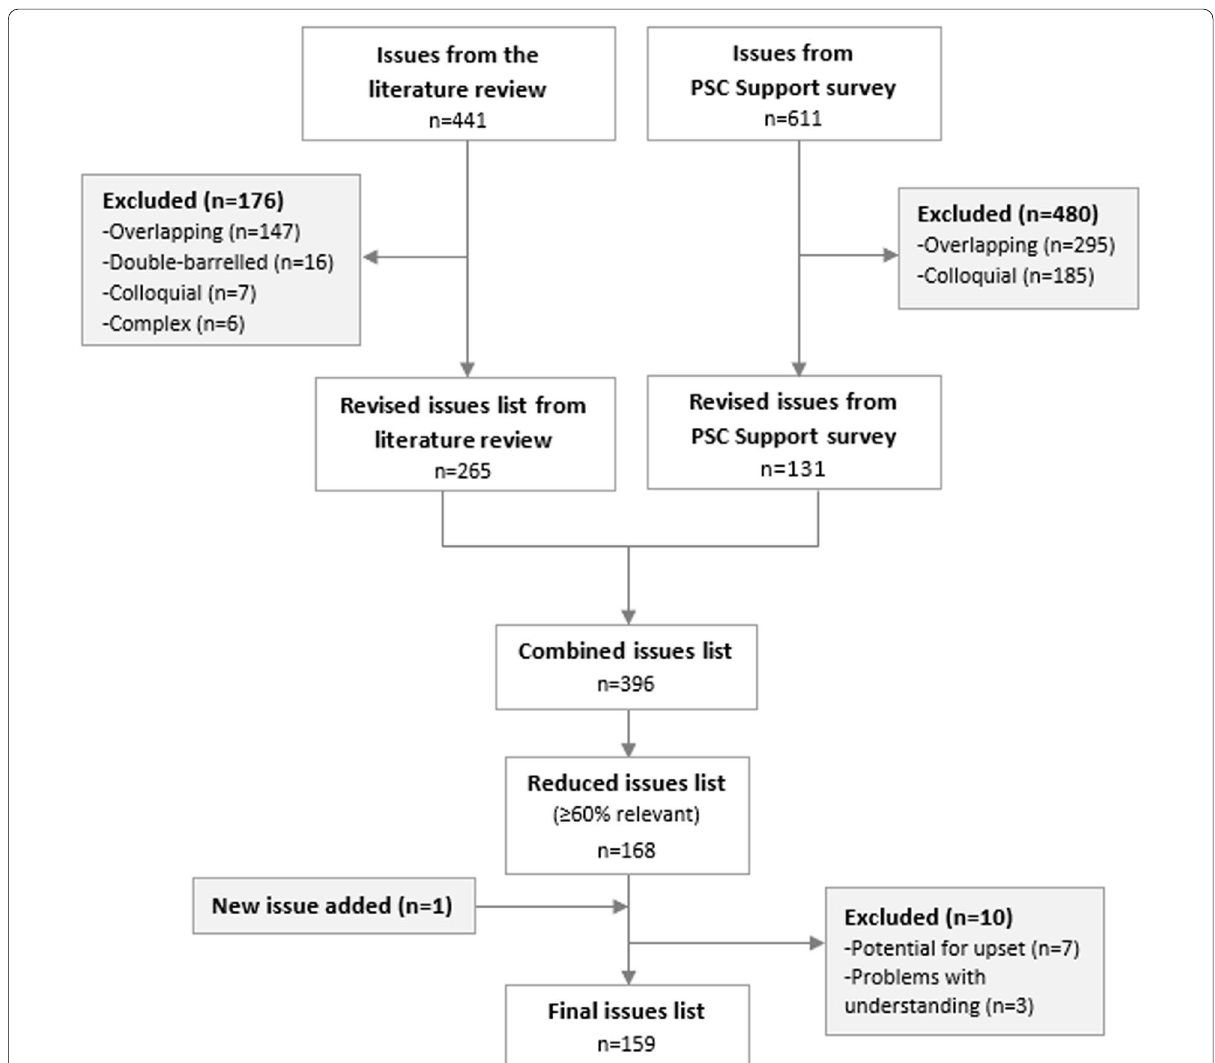
Fig. 1 Retention and exclusion of issues identified from the PSC Support survey and the literature review of existing QoL tools